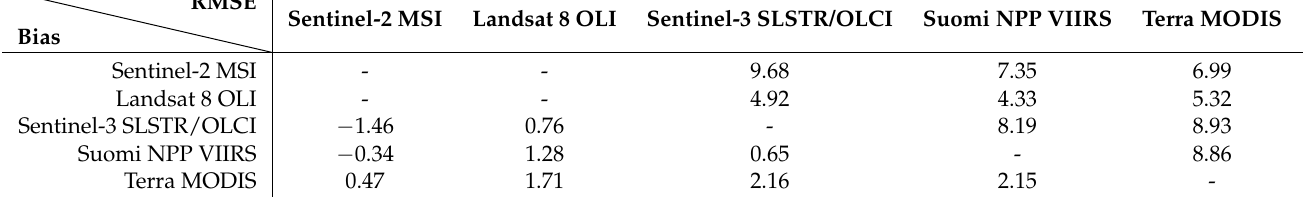
Table 4. Comparison of SCF maps using the LAMSU method for different medium-resolution sensors. The lower and upper triangle show the multi-sensor SCF bias (column minus row) and multi-sensor RMSE in percent SCF, respectively. Further details can be found in Table A1. SCF maps from Sentinel- 2 MSI and Landsat 8 OLI are calculated at 25 m, Sentinel-3 SLSTR/OLCI at 250 m, Suomi NPP VIIRS at 500 m and Terra MODIS at 1000 m.